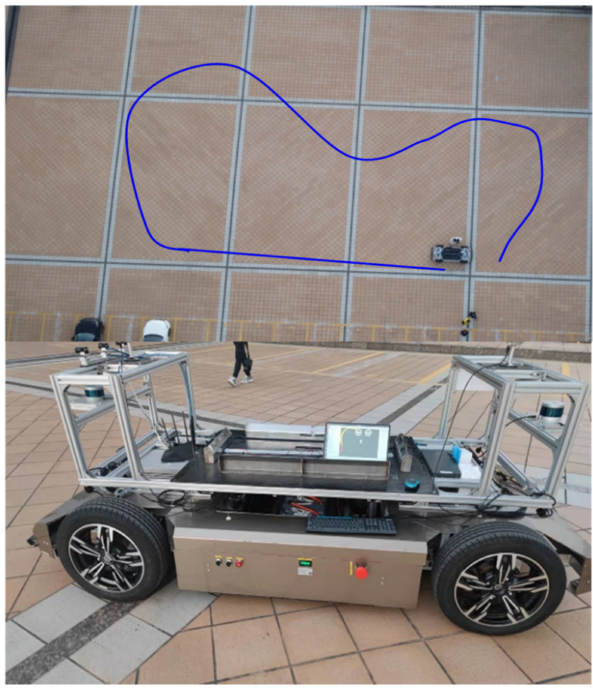
Figure 10. Experimental site and